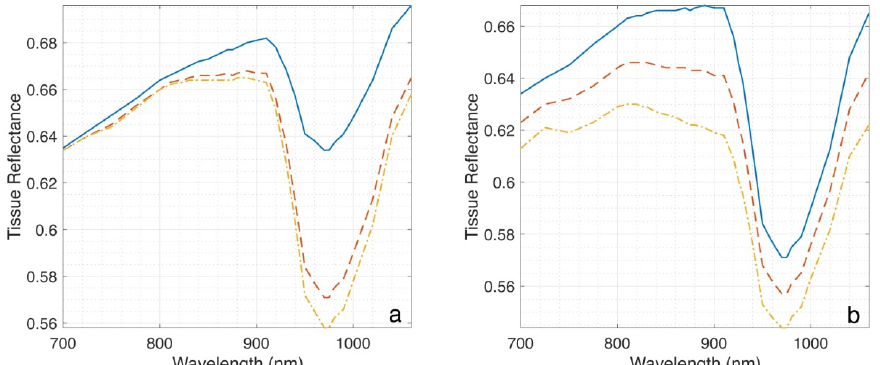
Figure 1. Panel ( a ): tissue reflectance at different water contents: 0.7, 0.8, and 0.3 (red, yellow, and blue lines, respectively). Panel ( b ): tissue reflectance at different blood contents: 0, 0.01, and 0.02 (blue, red, and yellow lines, respectively). SO 2 was set to 0.7.